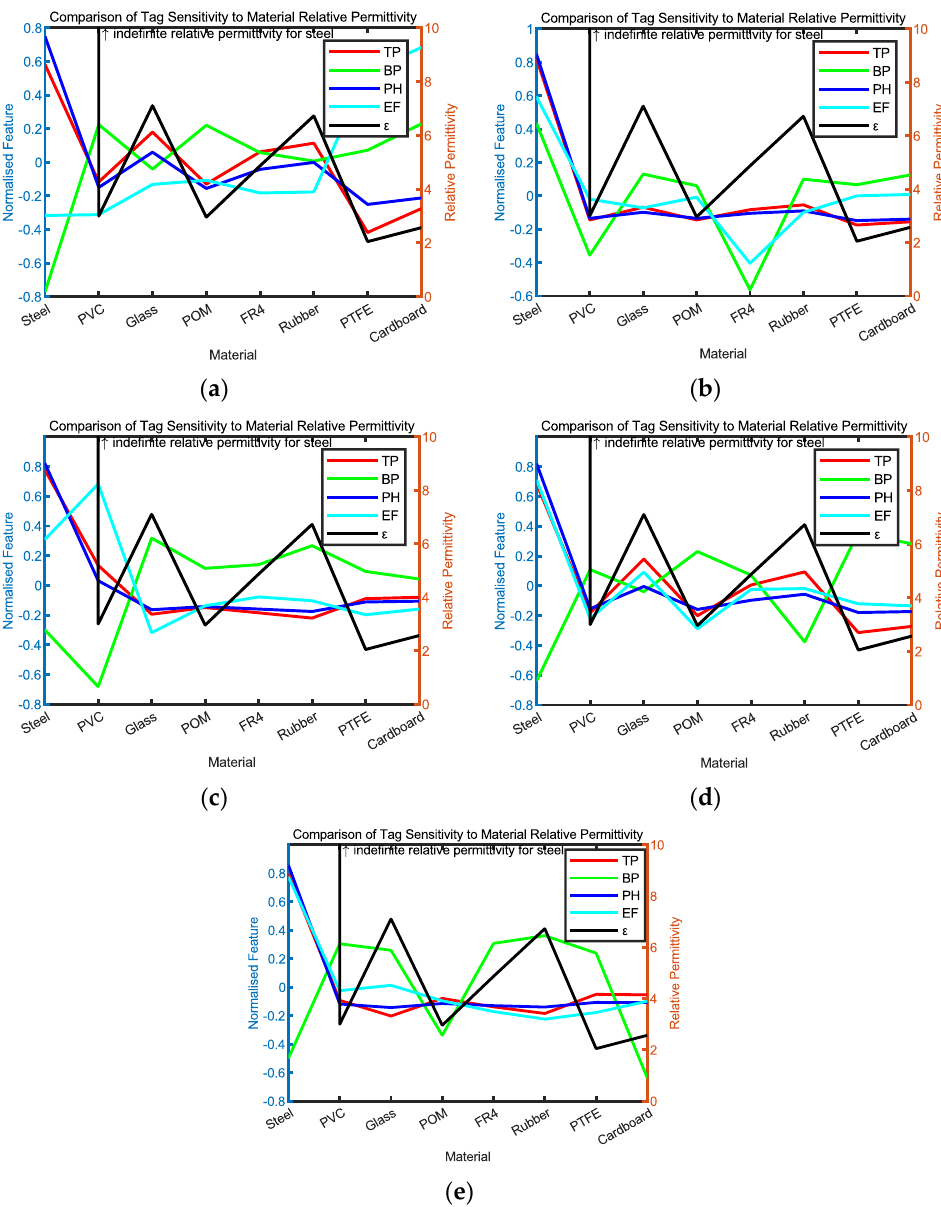
Figure 7. Measured parameters for different transponders ( a – e ).